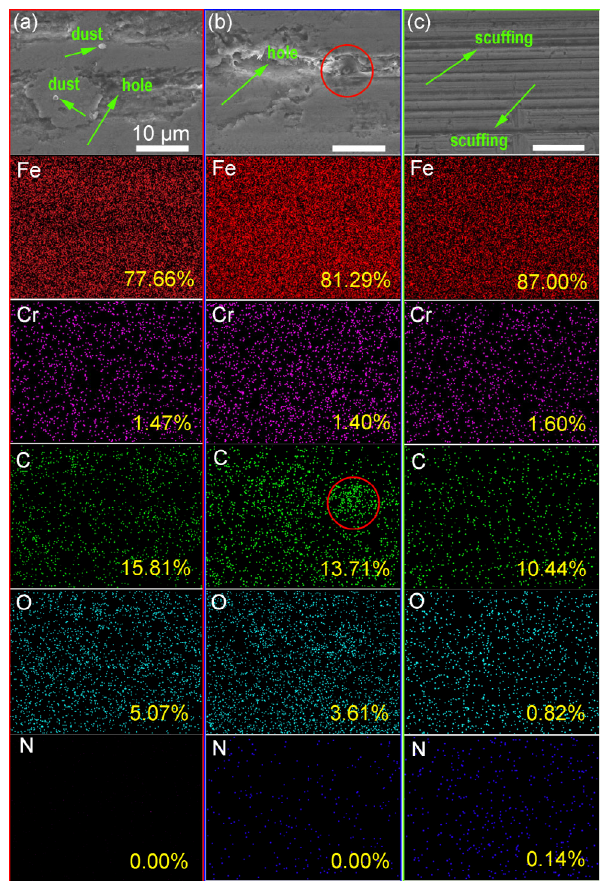
Fig. 15 SEM images and the corresponding EDS elemental mappings and elemental contents (inserted as the yellow atomic percents) of wear track surfaces lubricated with (a) PEG200, and (b) A-g-CNPs and (c) C-g-CNPs dispersions (0.7 wt%) in PEG200 under the conditions of 100 N and 200